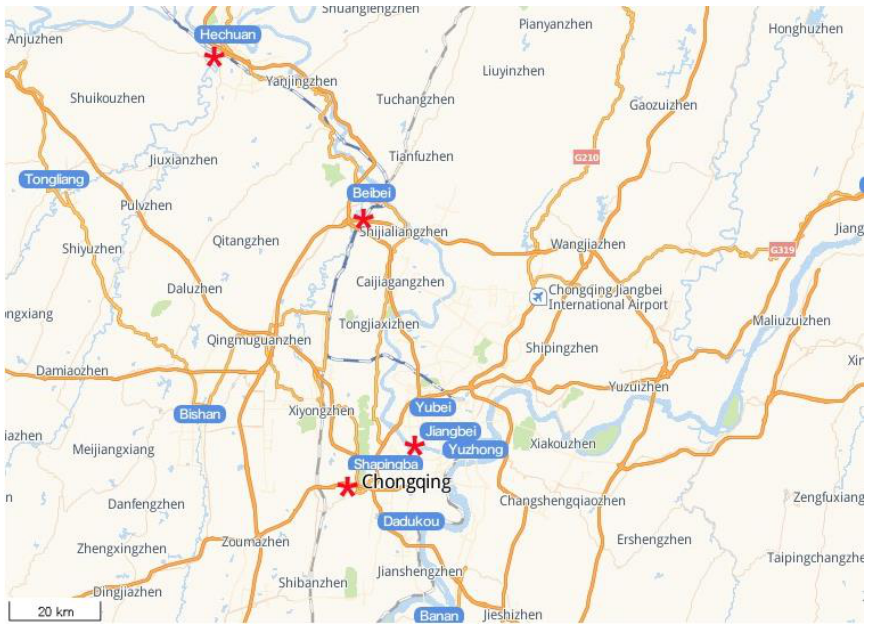
Figure 1 . Sample collection site,